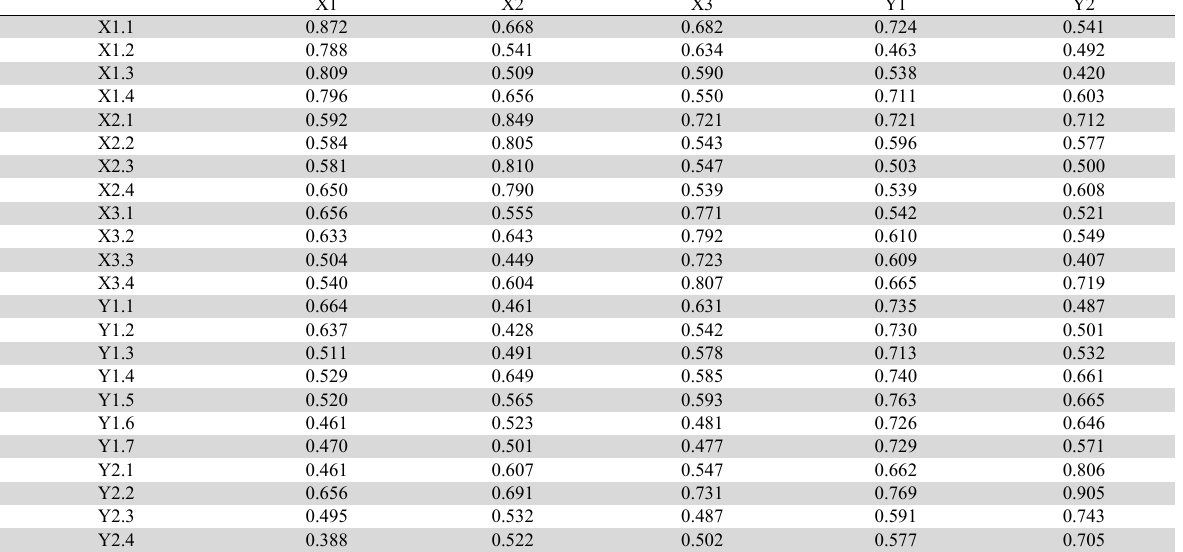
Discriminant Validity Measurement